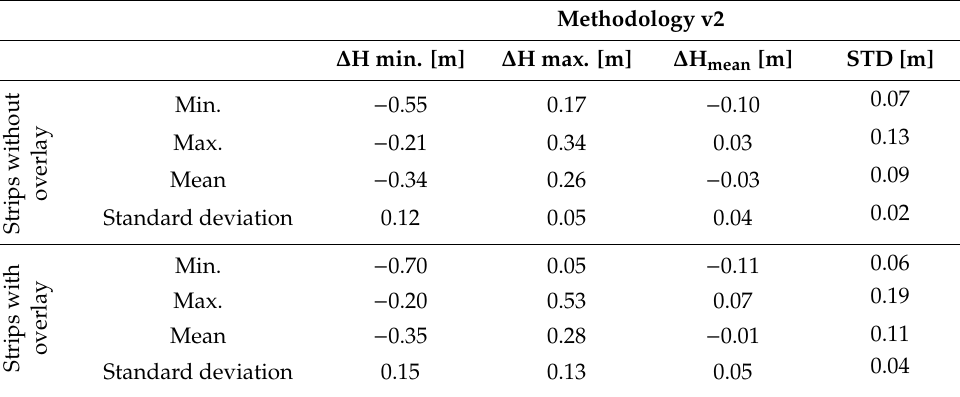
Table 9. Statistical characteristics for height di ff erences between strips (methodology v2). (H—height, STD—standard deviation).